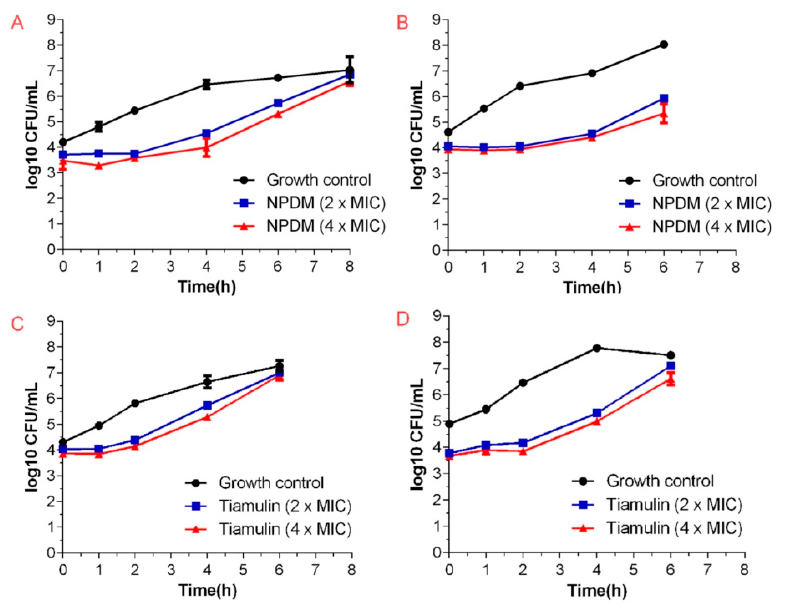
Figure 3. The bacterial growth kinetic curves for MRSA ATCC 43300 exposed to NPDM for 1 h ( A ) or 2 h ( B ) and tiamulin for 1 h ( C ) or 2 h ( D